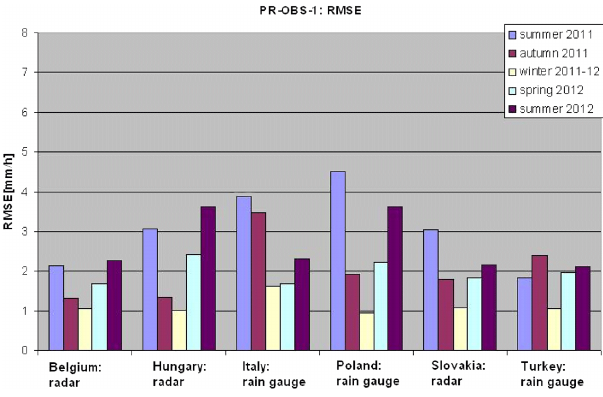
Fig. 11. The seasonal RMSE of PR-OBS-1 evaluated by the PPVG. The product reaches the best performances during the winter period in all the